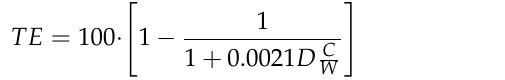
Figure 3. ( A ) Gravity check-dam in the study area, ( B ) drying the sediments samples in a heating chamber, ( C ) weighing of the samples.